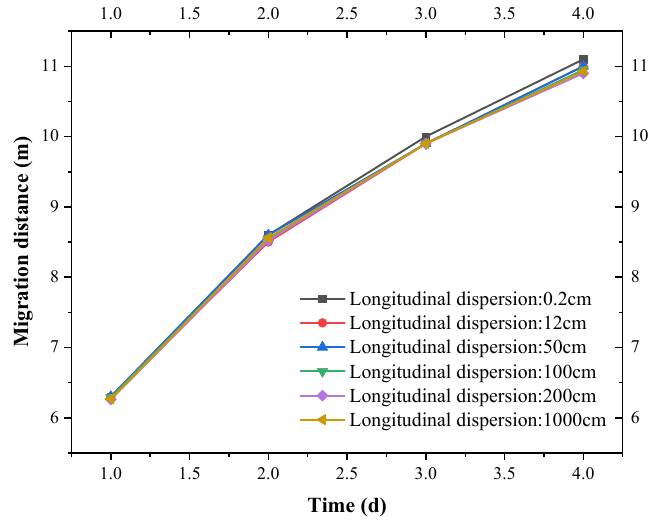
Figure 5. Migration distance of different dispersions varies with time.